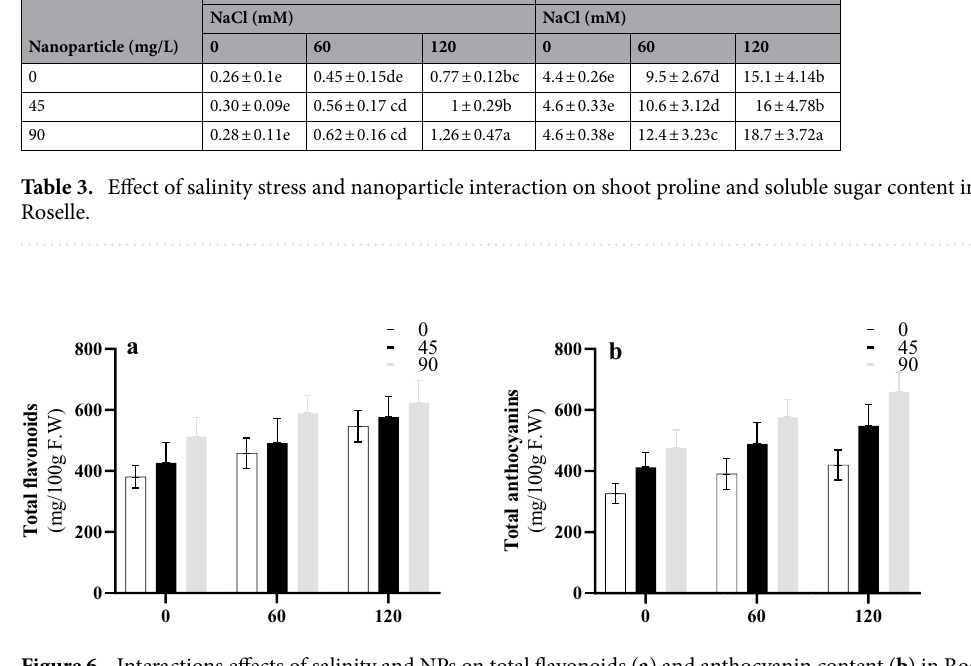
Proline (mg/g dry matter)